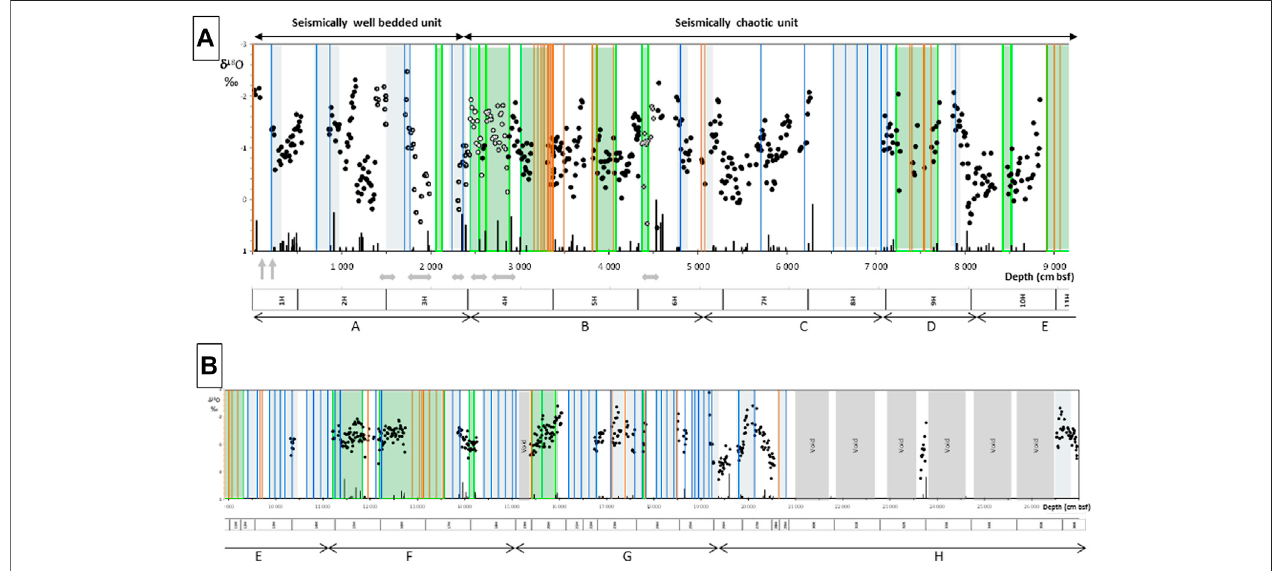
FIGURE6| Syntheticlogsand δ 18 OvaluesofcoreU1399A. (A) 0 – 90 mbsf. (B) 90 – 270 mbsf. δ 18 Odata:dotsU1399A;opencircles:sedimentaryunitsdisplaced by submarine sliding ( “ duplicate units ” ). Blue domains: turbiditic zones; blue bars: turbidites > 50 cm; black bars: tephra units; orange bars: debrites. The height of the bars relates to the relative thicknesses of the deposits. Green domains: deformed zones; gray domains: void in core. Gray arrows: the horizontal arrows indicate the duplicate units, and the vertical arrows indicate the fi rst two sediment gaps identi fi ed in the upper part of the core (they correspond to the gray domains in Figure7A ;seethetextforfurtherexplanations).Lettersarethedifferentcoresectionlabelsandlithologicalunits(see Figure3B ).Thereaderisreferredtohigh-resolution fi gure on the web version of this article for bene fi